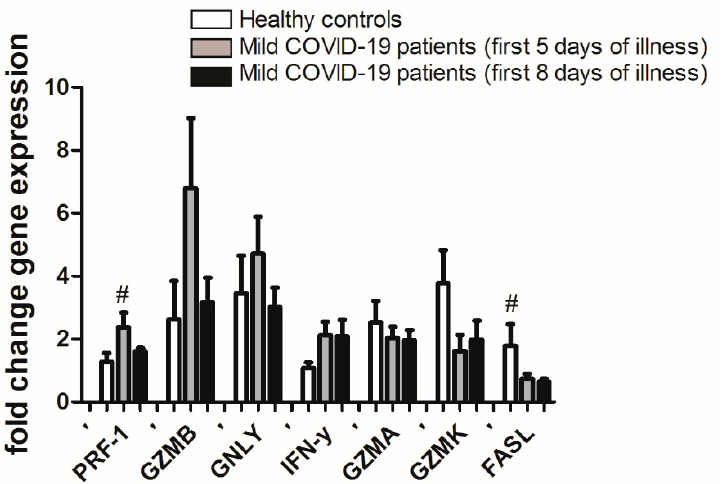
Figure 1. qPCR mRNA fold change of PRF-1, GZMB, GNLY, IFN- γ , GZMA, GZMK, and FASL in CD8+ T cells from peripheral blood of mild COVID-19 patients at the fifth and eight day of the disease ( n = 12) compared to heathy controls ( n =9). Data is presented as mean value ± standard deviation. # p value 0.05 (Two-way ANOVA followed by Tukey’s multiple comparison test). 3.3. Lymphopenia with Relative Decreases of CD8+ Effector Memory Subsets Define First Week of COVID-19 Infection